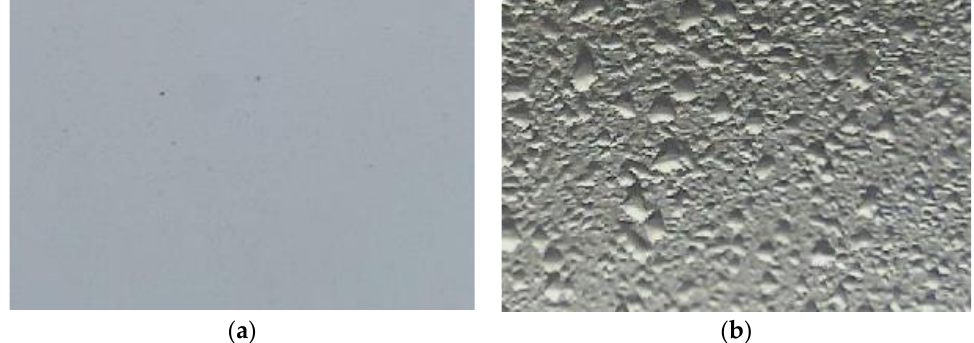
Figure 8. Examples of images used in the training and test datasets: ( a ) “dry” class image and ( b ) “wet” class image.